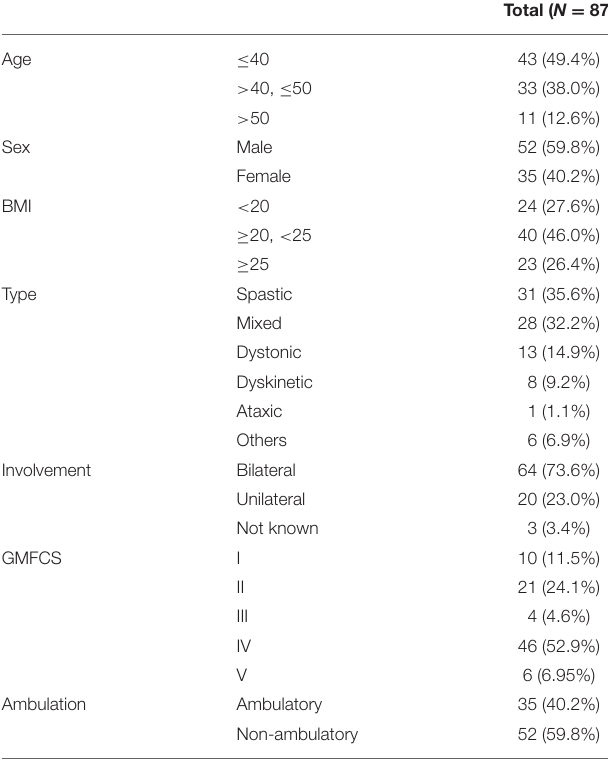
BMI, body mass index; GMFCS, Gross Motor Function Classification